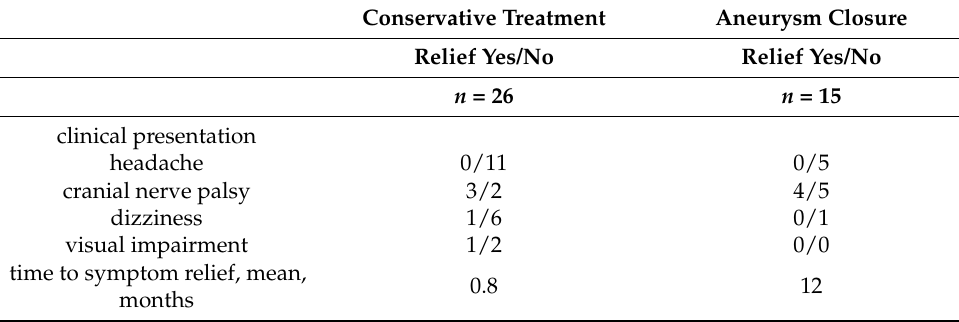
Table 3. Outcome of symptomatic